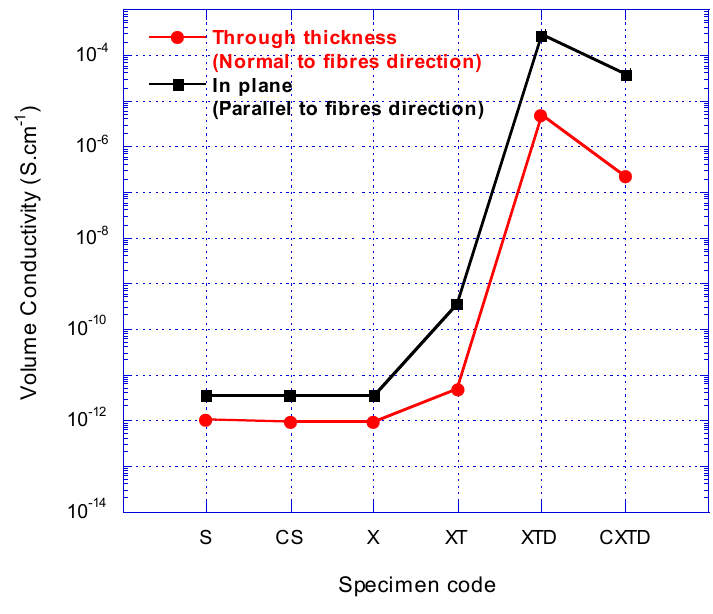
Figure 13. Electrical volume conductivity of various conventional and CNT-deposited GFRPs.